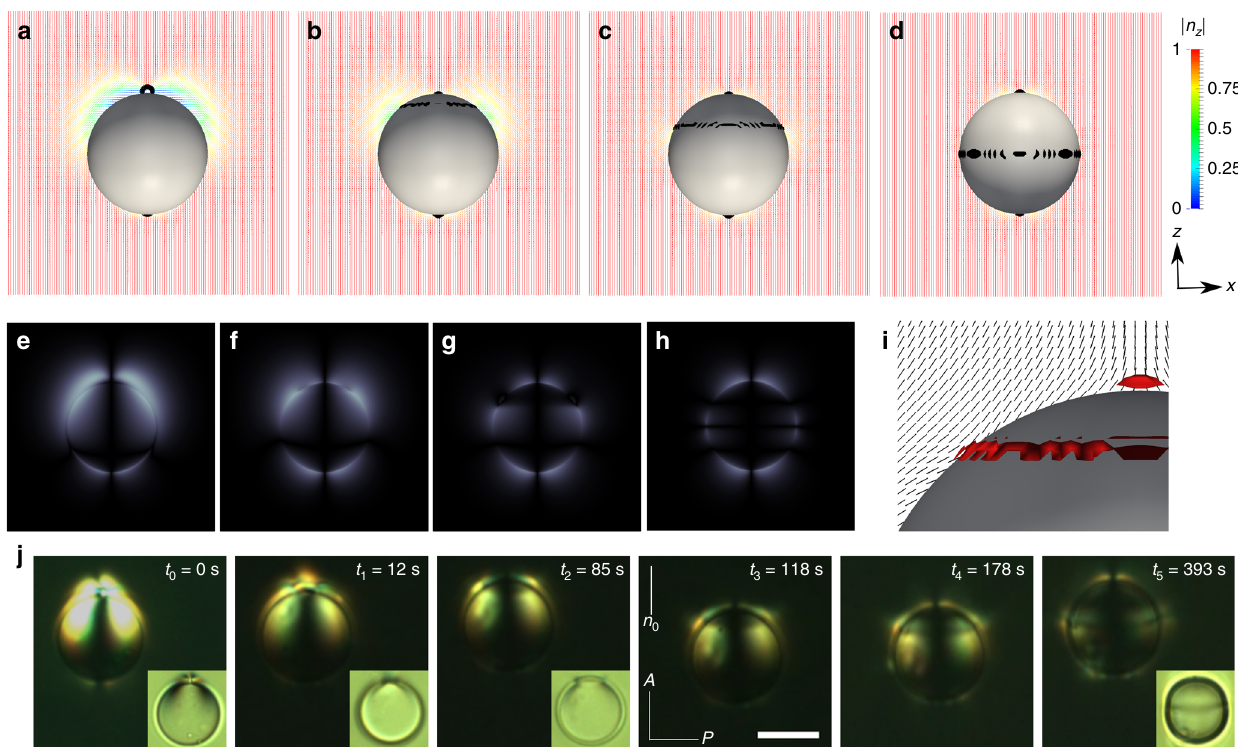
Fig. 4 Dipole-hexadecapole transition. a – d A temporal sequence of con fi gurations during relaxation after applying θ e = 60° to an equilibrium elastic dipole of θ e = 45°. The director fi eld is colored by its projection onto the z -axis, and the defects are shown in black (isosurface for S = 0.6). e – h Corresponding simulated polarized light textures. i Director fi eld near the defect ring in b . The director fi eld is shown in black and the defects are shown in red (isosurface for S = 0.6). j Experimental sequence of microscope textures showing the transition from a dipolar to a hexadecapolar structure taken between crossed polarizers. The fi rst texture is slightly overexposed compared to the others in order to enhance the visibility of a boojum defect at the bottom pole. Insets show corresponding textures taken between parallel polarizers. The size of the bottom side of the inset image is 9.5 μ m. Scale bar: 5 μ